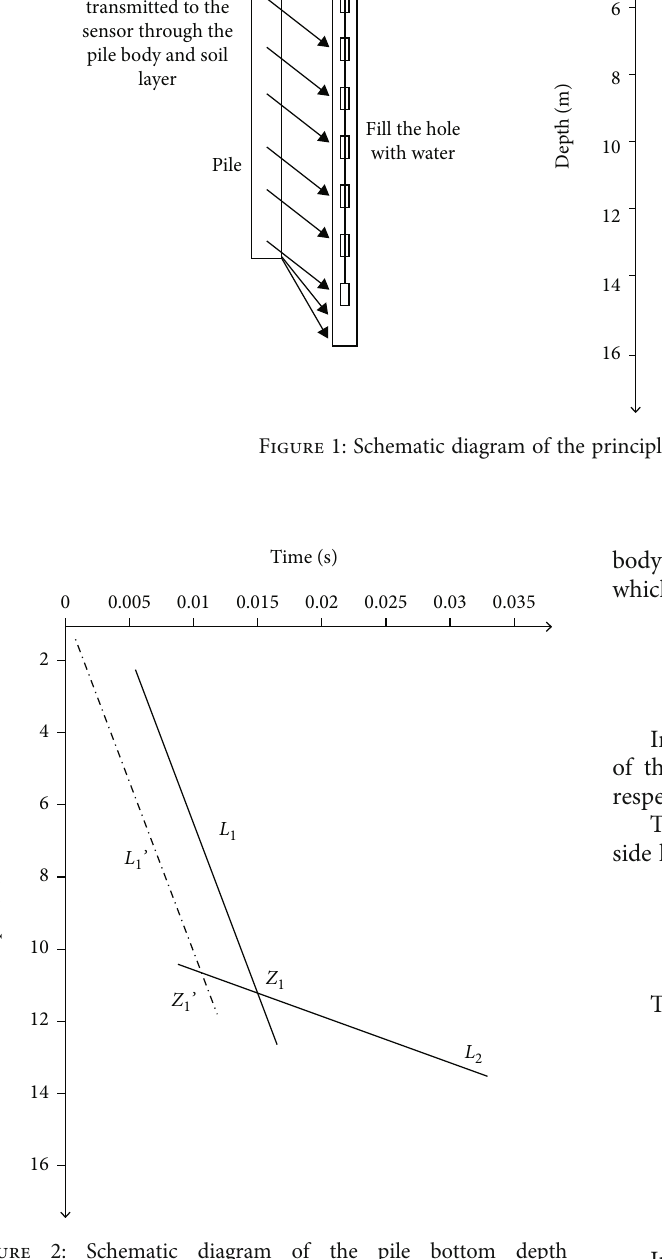
Figure 2: Schematic diagram of the pile bottom depth determination